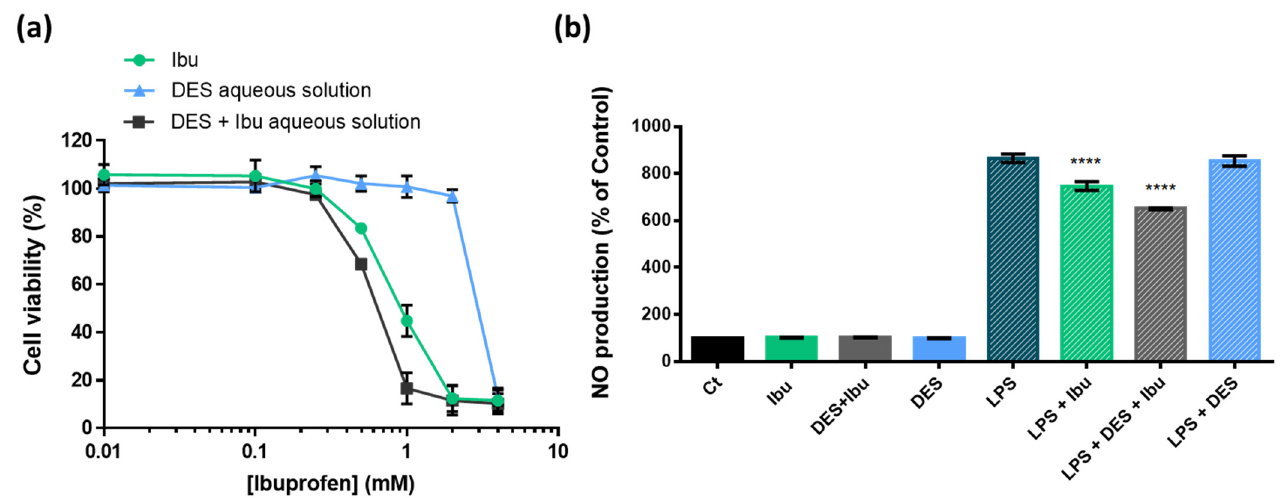
Figure 4. Effect of ibuprofen, Arg:Gly aqueous solution (60% w / w ) and ibuprofen solubilized in Arg:Gly aqueous solution on the ( a ) cell viability profile of Raw 264.7 macrophages, measured by the metabolic conversion of resazurin; and on the ( b ) anti-inflammatory action evaluated by the NO production of Raw 264.7 macrophages. Results were expressed relative to the control as mean ± SD of three independent biological experiments. Statistically significant differences were using one-way ANOVA (**** = p ≤ 0.0001).